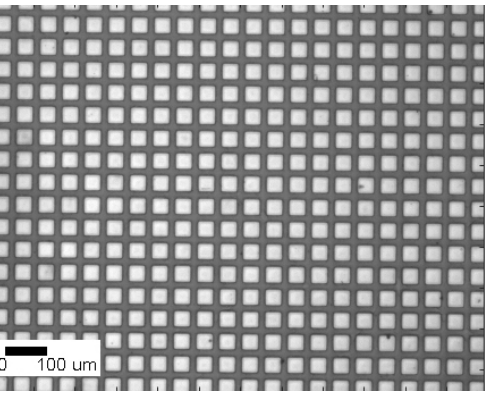
Figure 1. Optical microscope image showing the pixelated anode after all steps of the contact deposition process.